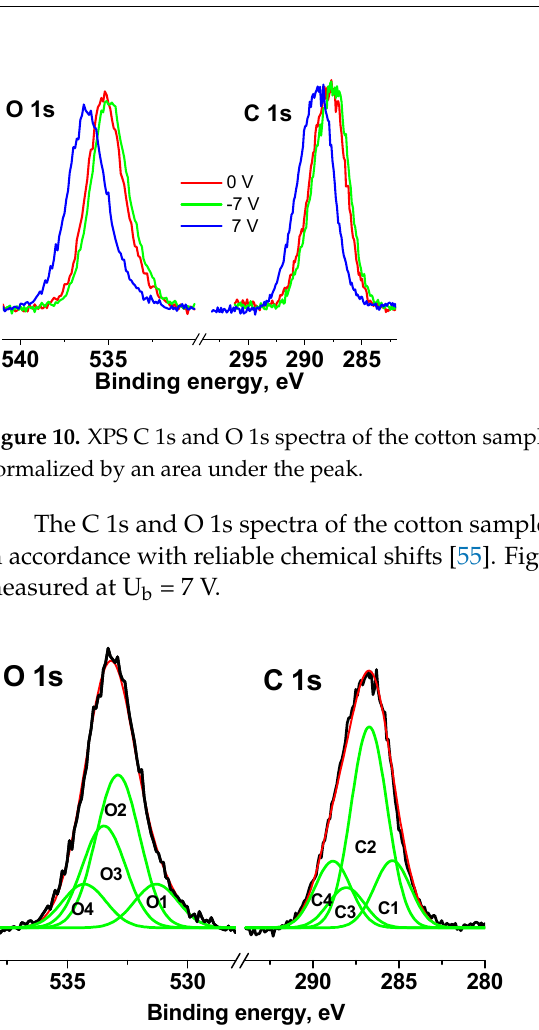
Figure 11. XPS C 1s and O 1s spectra of cotton sample measured at U b = 7 V. After taking into account the surface charge, the coincidence of the spectra is pre ‐ served, which indicates the uniform composition of cotton. Similar studies at different bias voltages were performed for Ag NPs/HBPAPES/cotton.